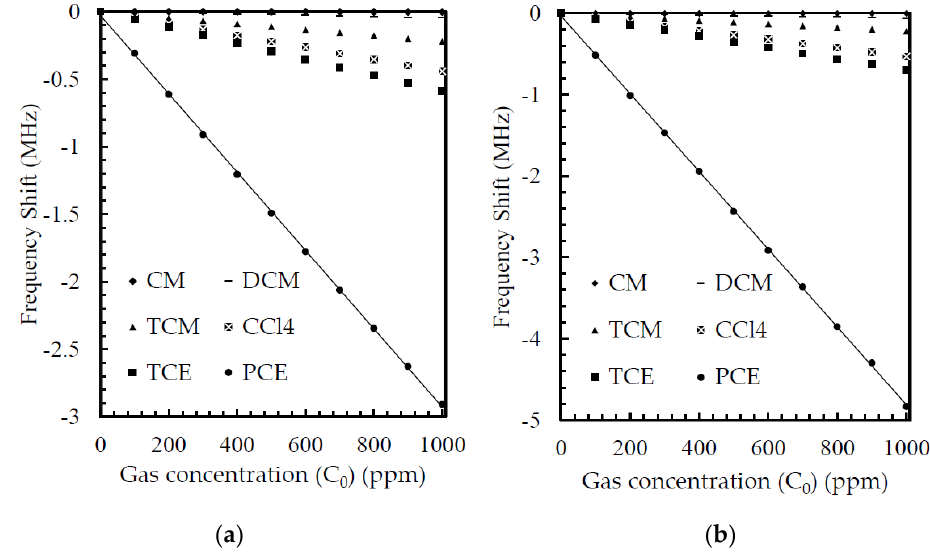
Figure 9. The frequency shifts of 1µm polyisobutylene-coated FBAR resonator exposed to various gas concentrations ranging from 1 to 1000 ppm, ( a ) without fractal electrode geometry, and ( b ) with fractal electrode geometry.